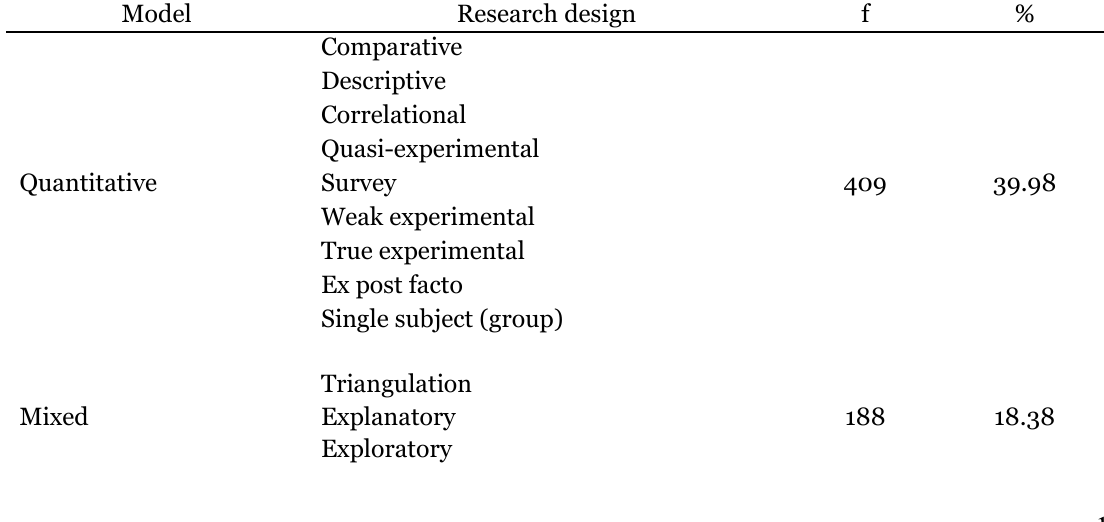
Distribution of Studies by Method